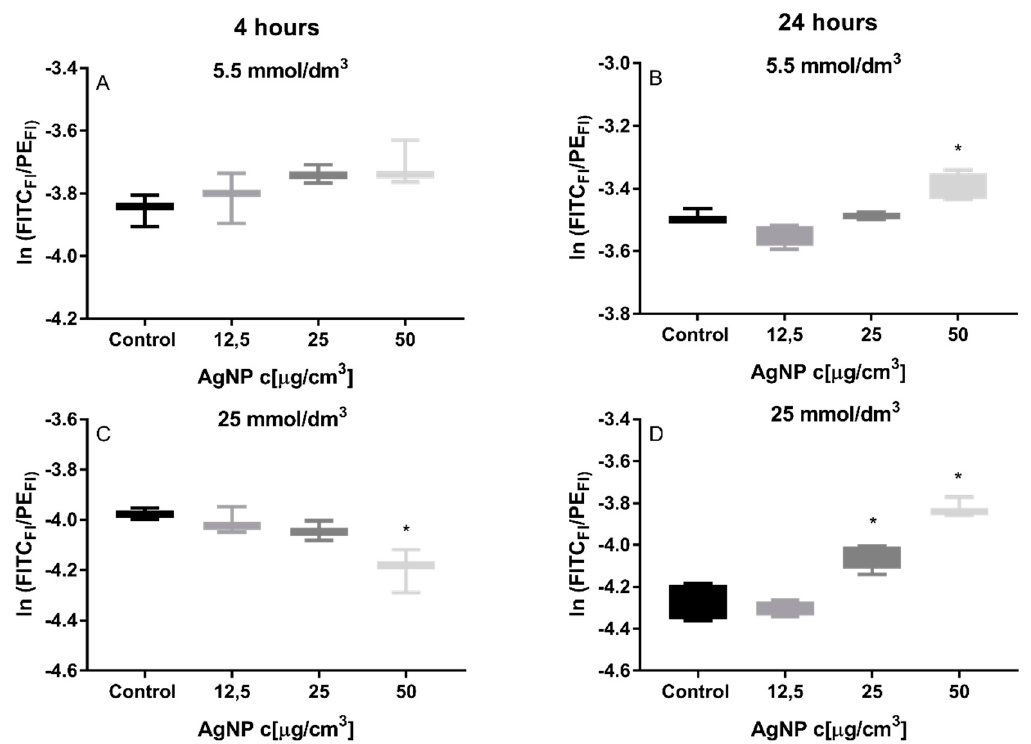
Figure 2. Generation of lipid peroxides in Hep G2 cell line grown in 5.5 ( A , B ) and 25 mmol / dm 3 ( C , D ) glucose media, exposed to silver nanoparticles for 4 ( A , C ) and 24 h ( B , D ). Cells were seeded in density of 5 × 10 5 per well and lipid peroxides were analyzed with flow cytometry (BODIPY ® 581 / 591 C11). * denotes statistically significant di ff erence compared to control (untreated cells). ANOVA followed by Dunnett’s post hoc test, n = 6, α = 0.05.